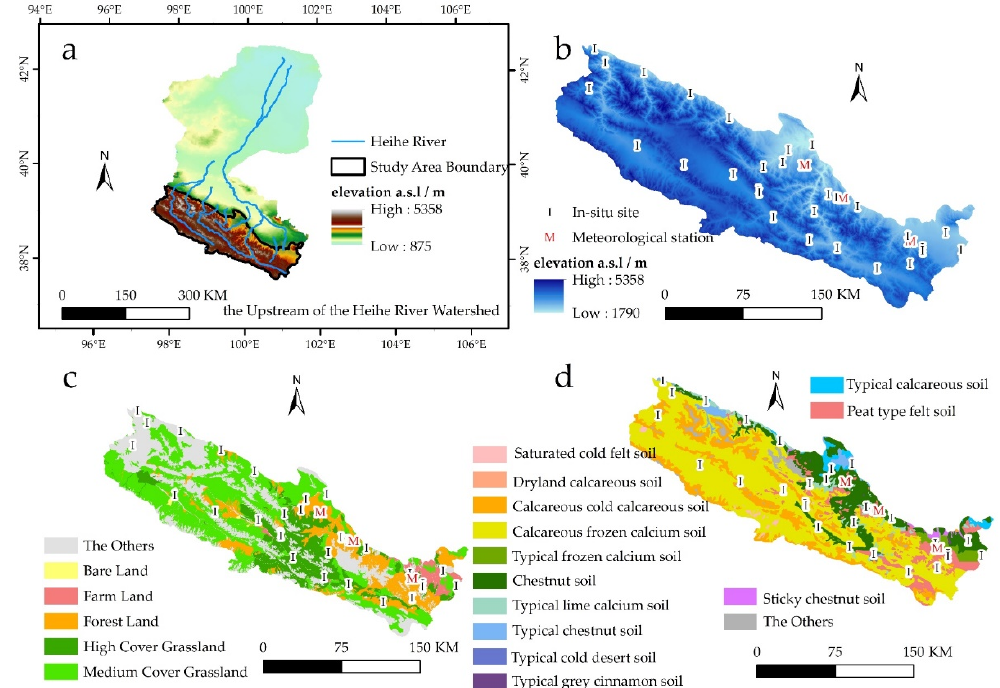
Figure 1. The in situ observation stations in the upstream of the Heihe River Watershed, Northwest China. The number shows 31 land use / land cover (LULC) soil elevation types (details in Table 1). ( a ) the study area in China; ( b ) the elevation of the study area, black circles represent the in situ sites and crimson circles represent the three automatic meteorological station sites; ( c ) land use types distribution in the study area; ( d ) soil types. The locations of in situ monitoring sites and meteorological stations are also indicated in ( b ), ( c ) and ( d ). Table 1. Soil and vegetation types at the in situ observation sites and automatic meteorological stations.